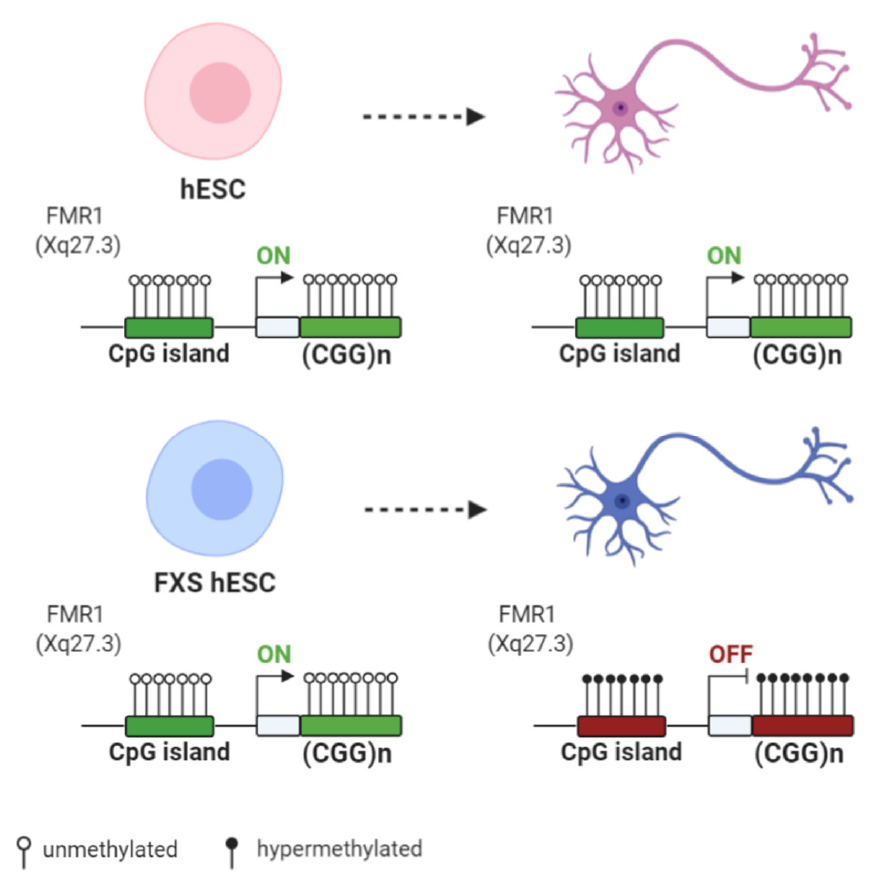
Figure 2. Differences of FMR1 methylation during differentiation of human embryonic stem cells (hESCs) derived from normal and FXS individuals: Both normal and FXS hESC have an unmethylated FMR1 promoter and similar FMR1 expression levels. Upon differentiation, the FMR1 promoter and the CGG expansion become hypermethylated in FXS hESCs, with the subsequent decrease of the FMR1 expression level. Created with BioRender.com.